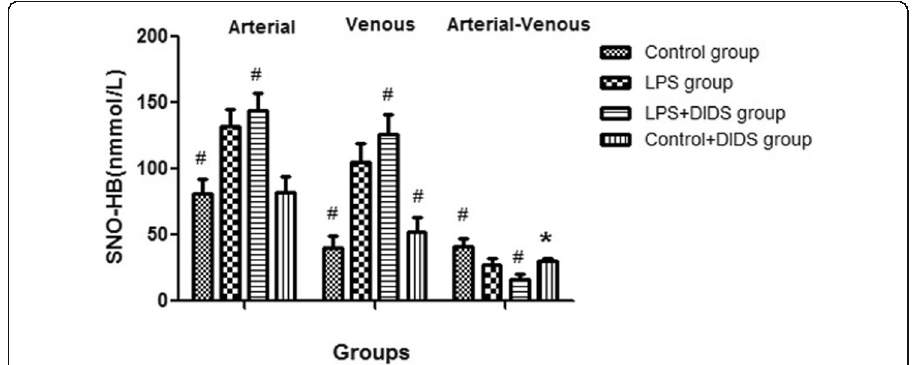
Fig. 1 The arterial and venous SNO-HB concentrations among four groups. The sign # represented the value in the group had statistical difference compared with LPS group ( P < 0.05); the sign * represented the value in the control + DIDS group had statistical difference compared with control group ( P <